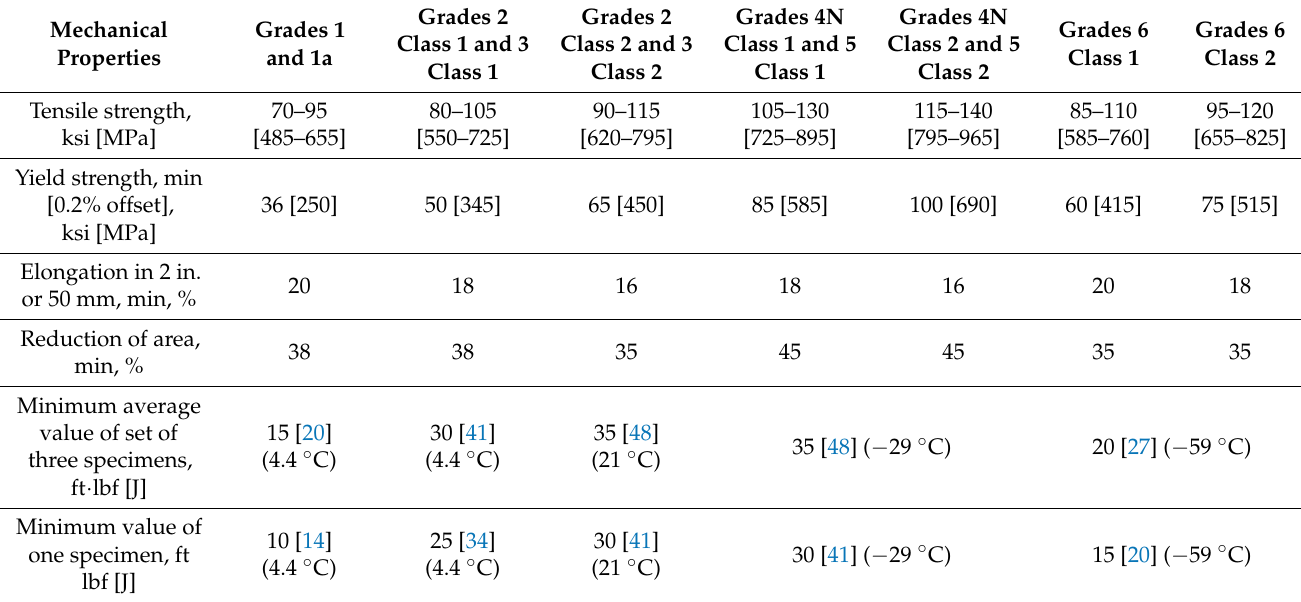
Table 4. The mechanical properties requirements [24].